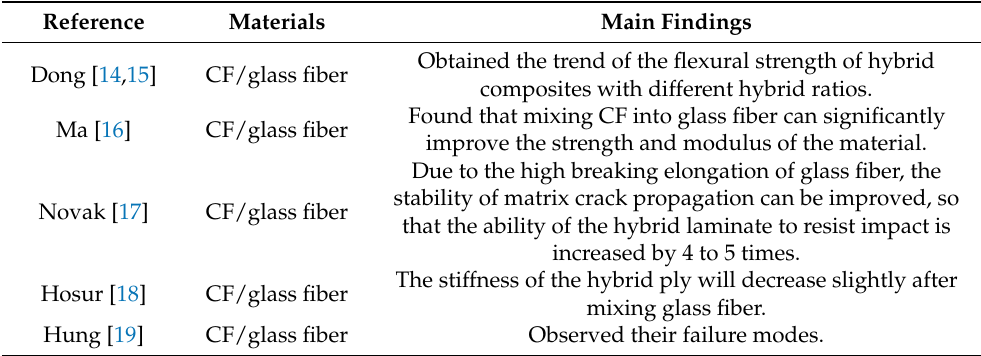
Table 1. CF and glass fiber reinforced hybrid composites.